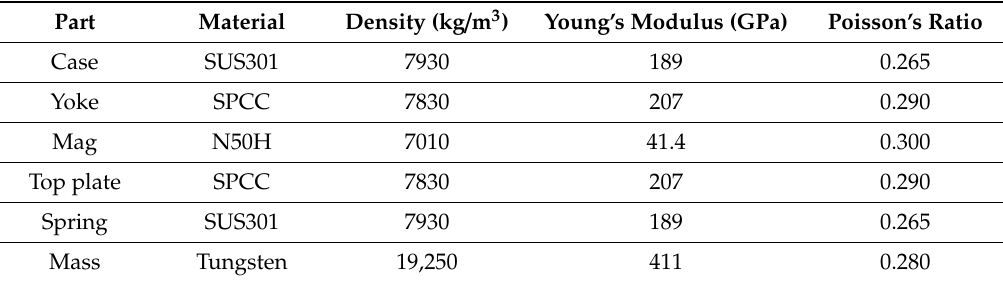
Figure 4. Nonlinear parameters and transfer function of the actuator. Table 1. Material